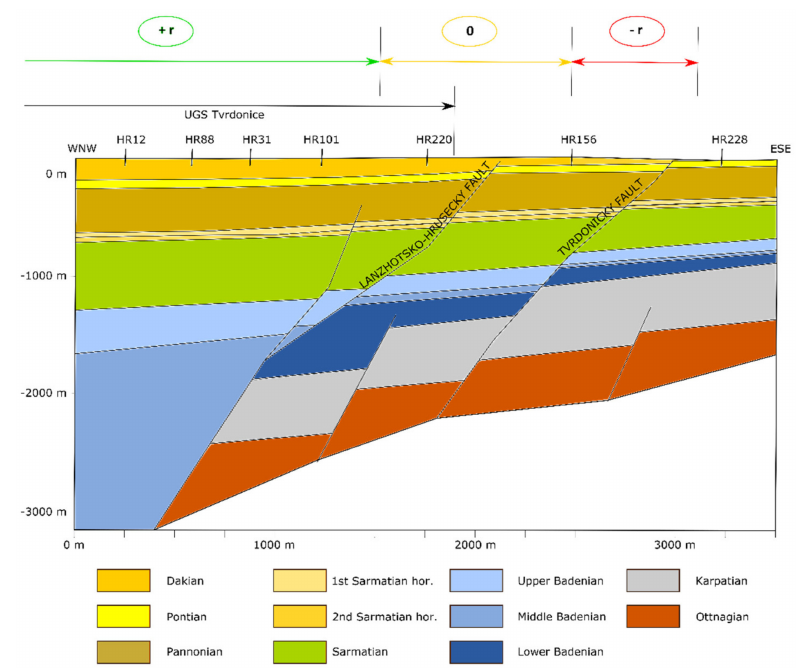
Figure 7. Schematic geological cross-section of the Tvrdonice UGS area. Above the cross-section, the eastern boundary of the UGS is noted, and also the areas with the synchronous direction of movement (green; + r), the transition area (yellow; 0) and the area with opposite direction (red; − r) are marked. Horizons in layers of Sarmat and Baden are used for the UGS (modified according to [44]).